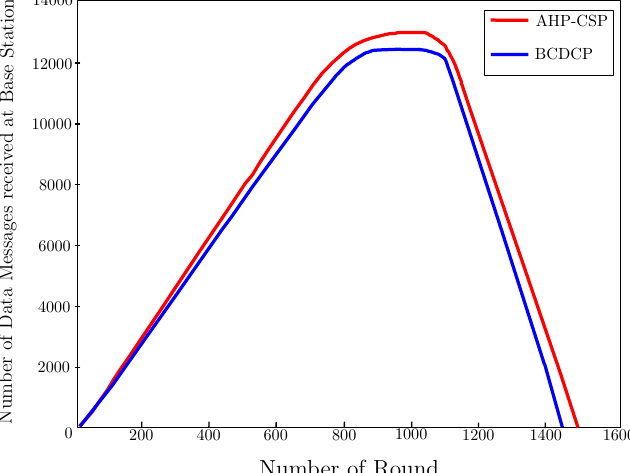
Figure 6. Total number of data messages received at the base station according to the number of operation rounds.